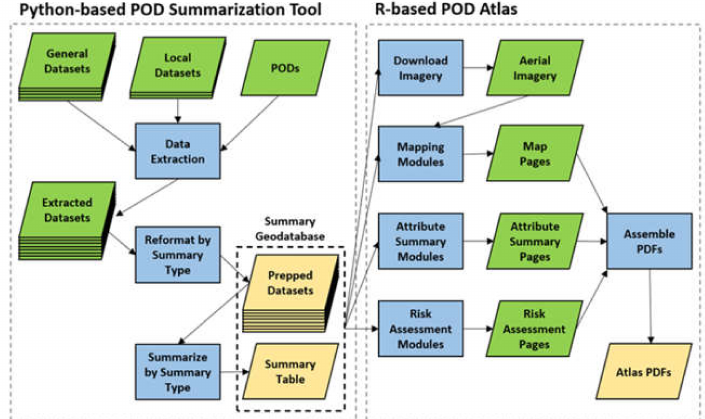
Figure 3. Workflow of POD Summarization and POD Atlas creation. Green parallelograms = input or intermediate data (e.g., spatial data and map page); blue rectangles = process; yellow parallelograms = final products. Asterisks denote fixed data in the atlas; all other atlas outputs are created with optional modules that can be run in parallel to create the desired map or data pages. Stacked symbols indicate multiple data sets are